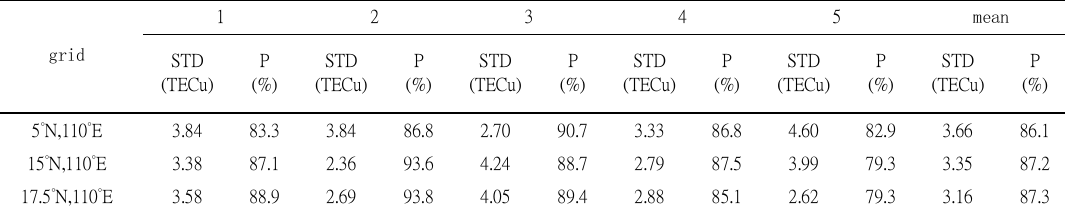
fig. 6 measured VTEC of IGS stations at middle, low and high latitudes in China Table 2 prediction accuracy statistics of eof-arima model at different latitudes in